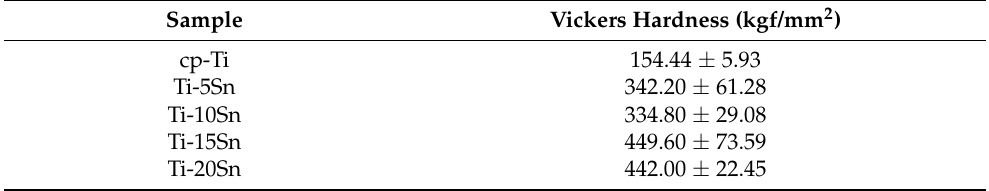
Table 1. Vickers hardness values of cp-Ti and Ti-xSn alloys (x = 5~20 wt%) ( n = 5).